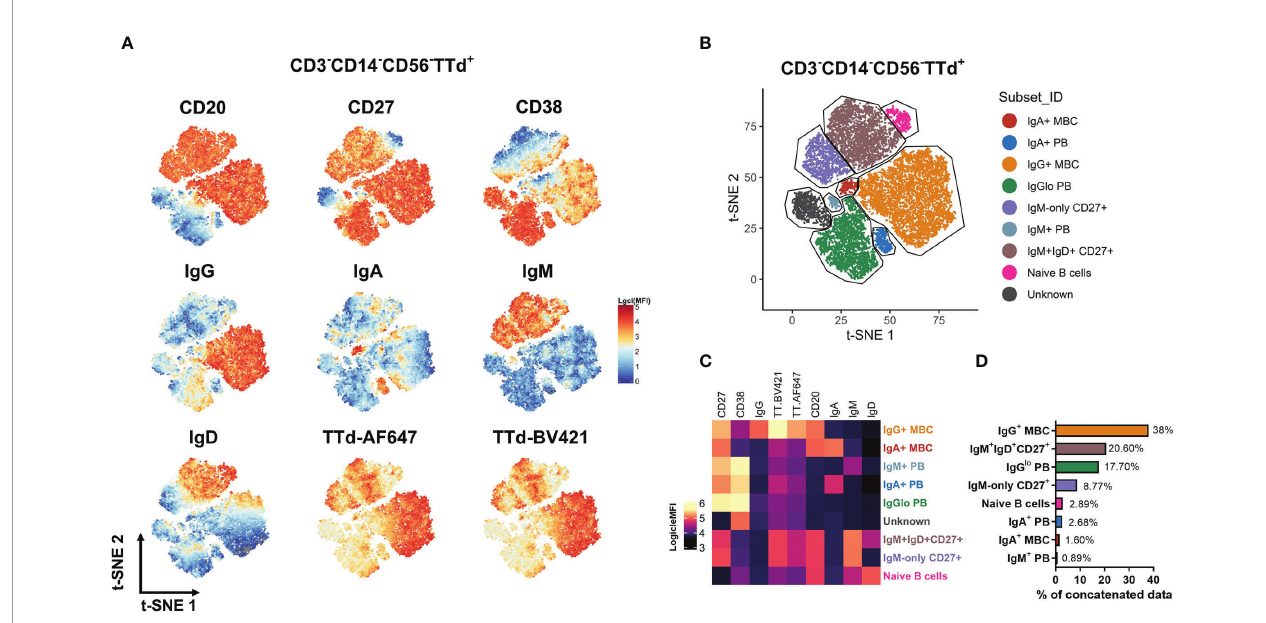
FIGURE 3 | De fi nition of TTd + B cell subsets by unsupervised analysis using t-SNE. From 3x10 5 CD3 - CD14 - CD56 - lymphocytes (n = 40; 10 individuals at 4 timepoints), TTd-BV421 + AF647 + events were exported as individual fcs fi les. The samples were then concatenated for t-SNE analysis. (A) Logicle-transformed MFI was displayed to examine the expression of each marker in the t-SNE dimension-reduced data. (B) Subsets were manually gated based on a combination of spatial separation in the t-SNE plot and the differential marker expression. (C) For each population identi fi ed, surface phenotype is shown on a heatmap. (D) Bar graphs denote the percentages of each t-SNE-de fi ned subset in the concatenated data set (all individuals across all